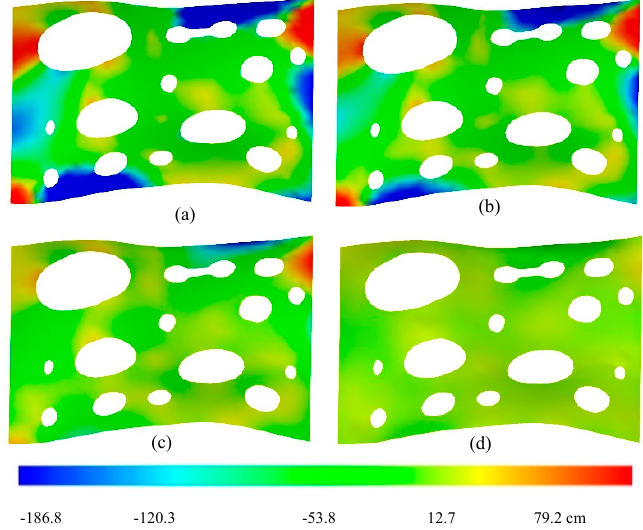
Figure 14. The z-displacement distribution of several structures in the evolution process. ( a ) Step1, 100%; ( b ) Step 50, 70.75%; ( c ) Step 111, 38.94%; ( d ) Step 296, 14.57%.